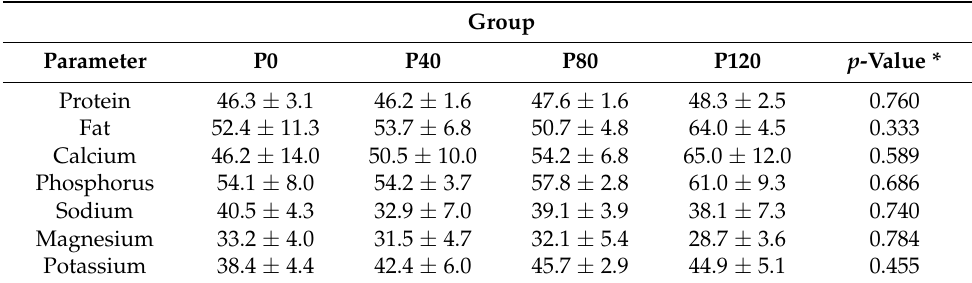
Table 5. Apparent net nutrient utilization of C. gariepinus